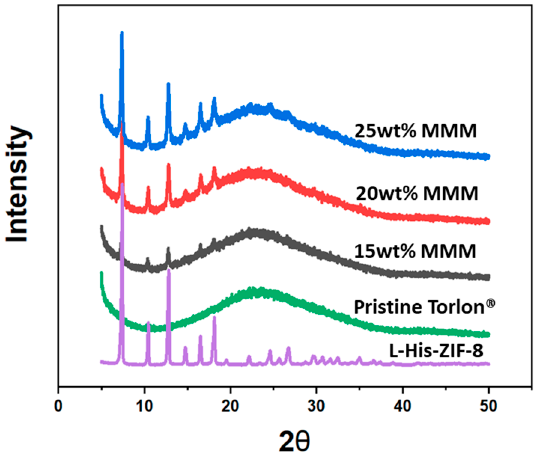
Figure 6. Thin Film X-ray diffraction of the fabricated L-His-ZIF-8/Torlon ® Mixed Matrix Membrane compared to the pristine Torlon ® dense membrane and L-His-ZIF-8 filler.